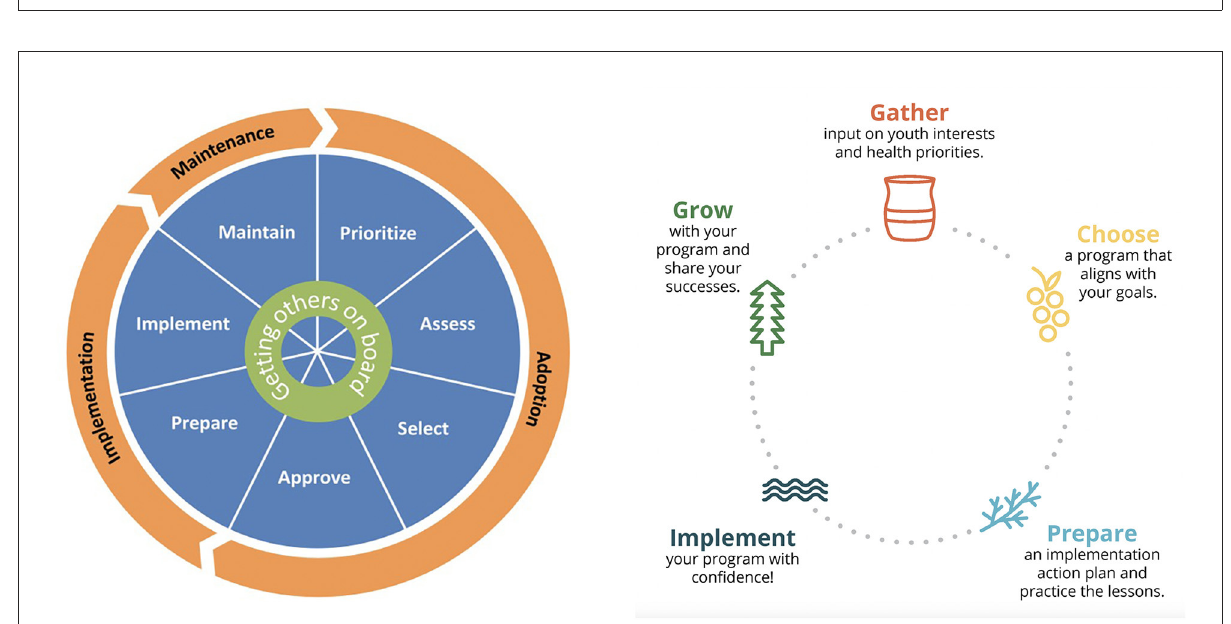
FIGURE3 Original CHAMPSS and adapted Healthy Native Youth Implementation Toolbox